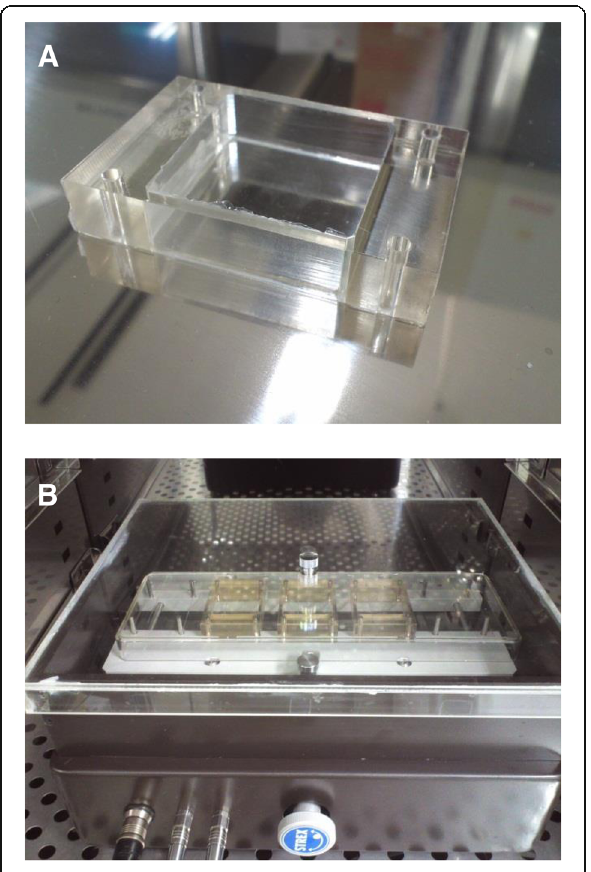
Fig. 1 Cell-stretching device. Silicon resin chamber STB-CH-10.0 ( a ). Cell-stretching device STB-140 ( b